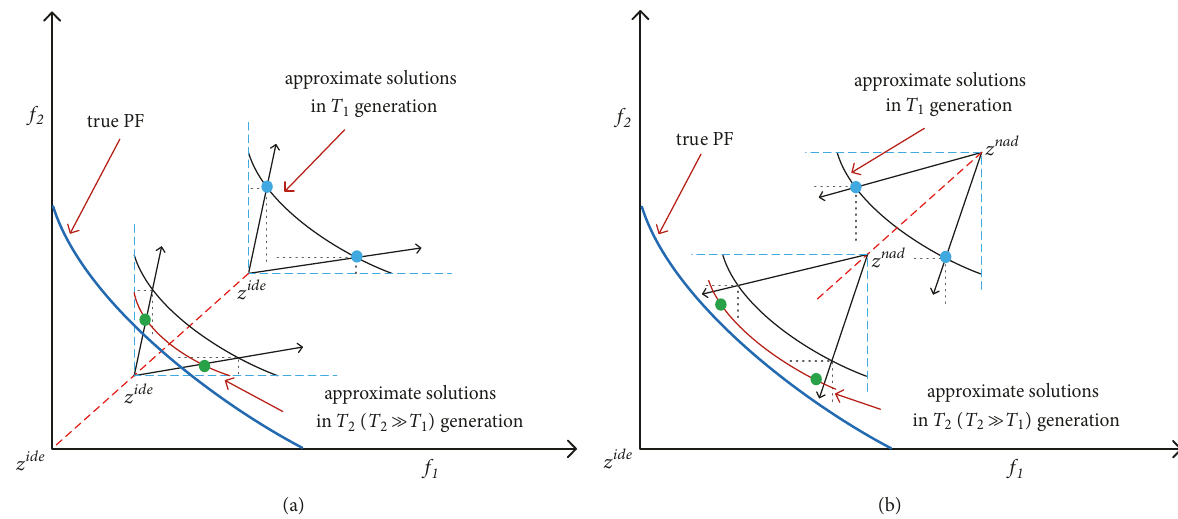
Figure 3: The missing of boundary PF parts in the cases: (a) the ideal reference point: (b) the nadir reference point.